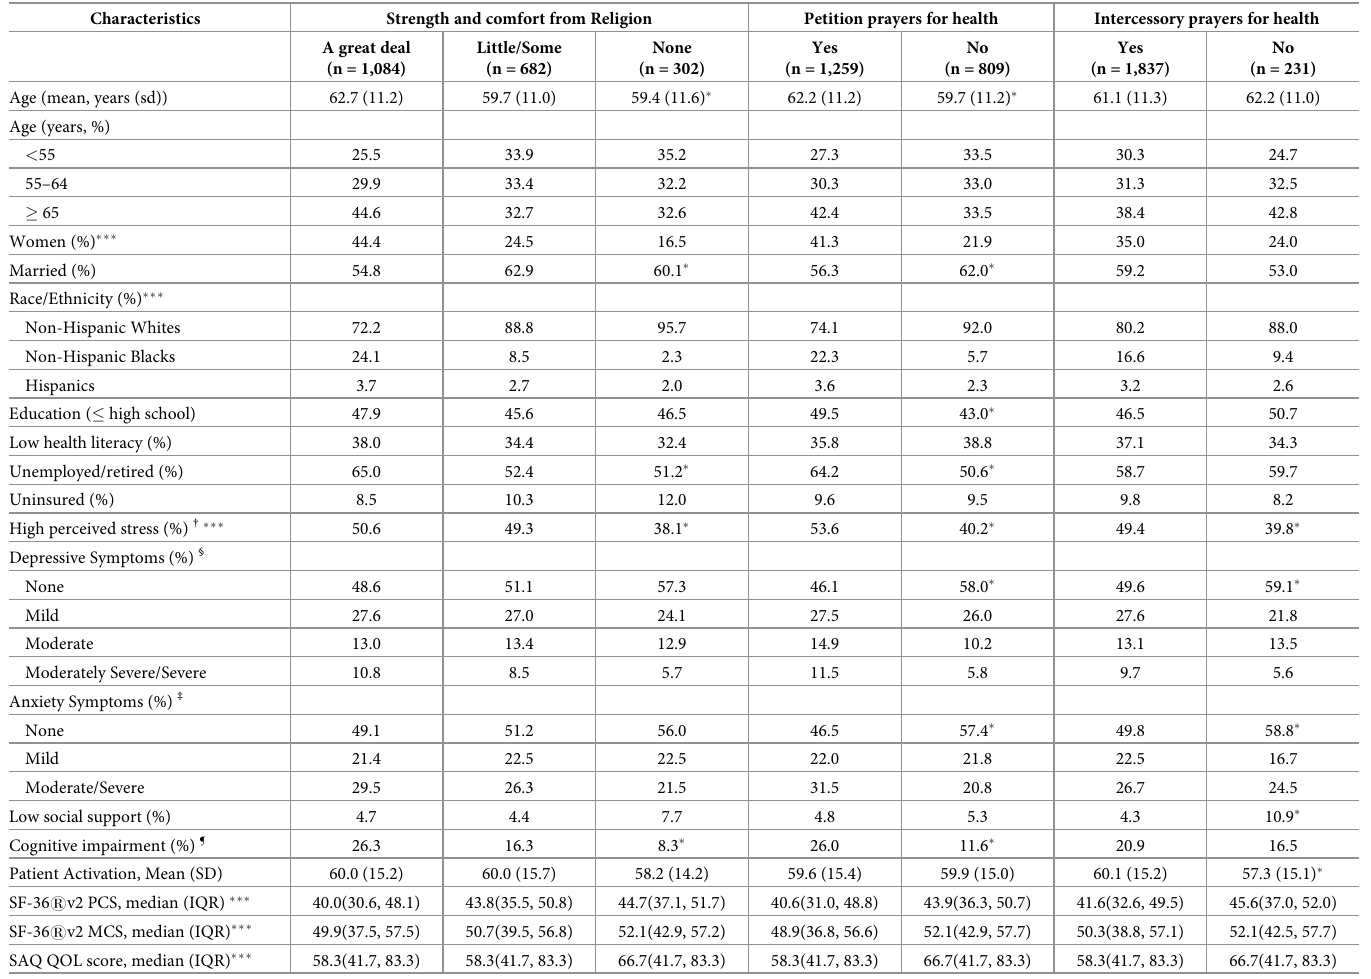
Table 1. Baseline sociodemographic and psychosocial characteristics of hospital survivors of an acute coronary syndrome by religiosity measures.